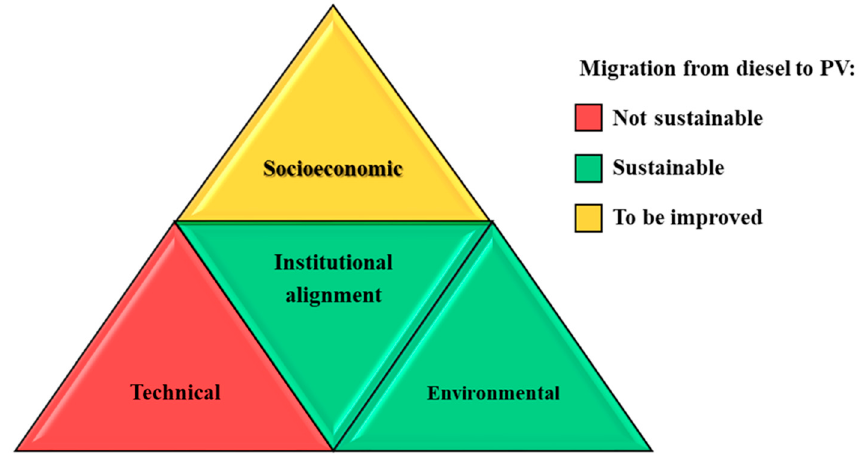
Figure 9. Sustainability of the migration from diesel to PV-based technologies.